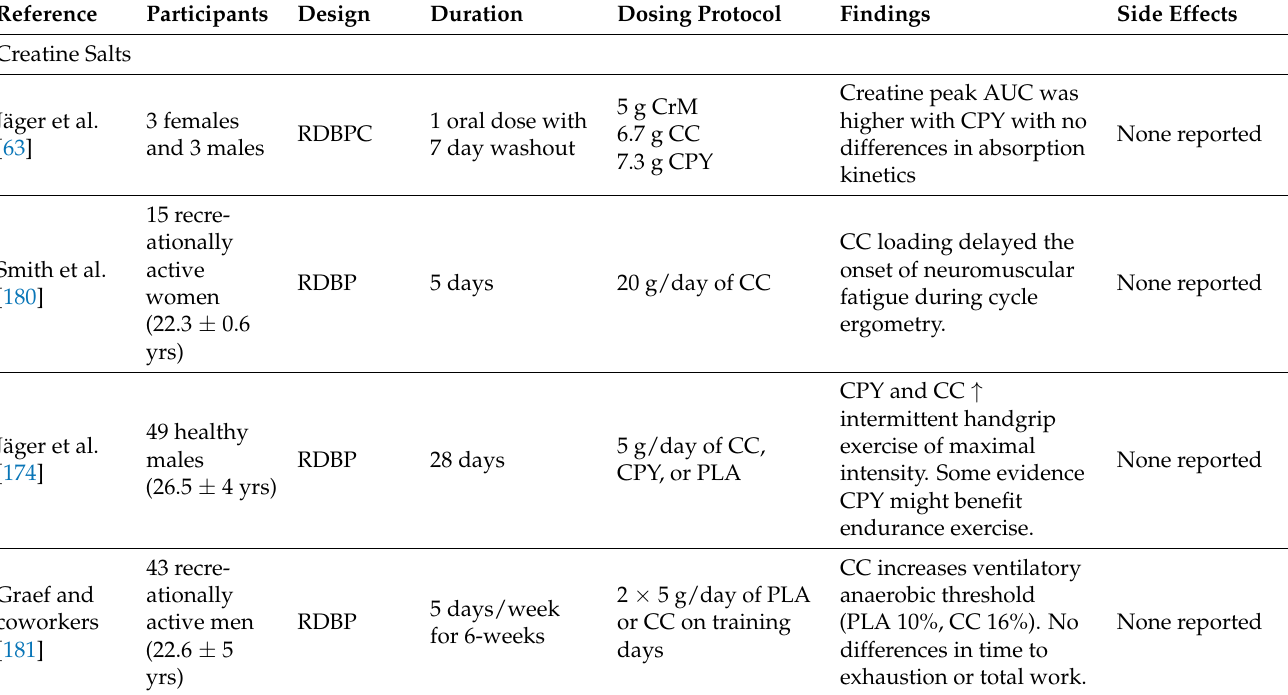
Table 3. Creatine containing compounds other than CrM with some evidence supporting bioavail- ability, efficacy, and/or